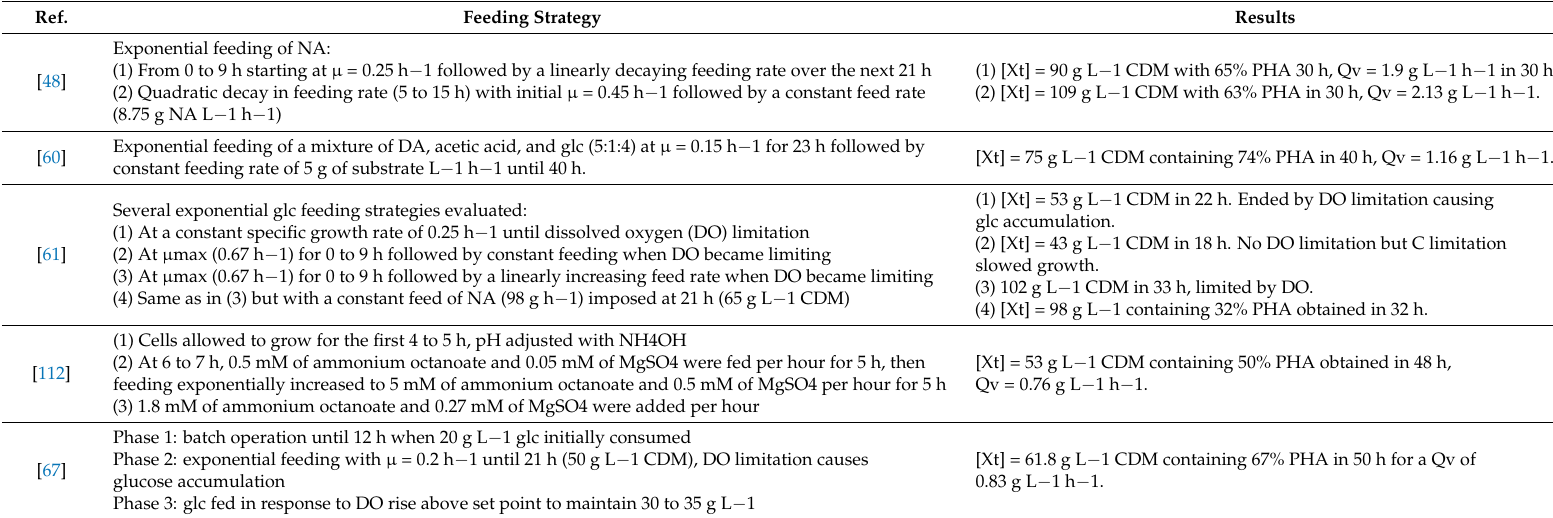
Table 3. Various feeding strategies used to obtain HCD cultures in mcl-PHA production.